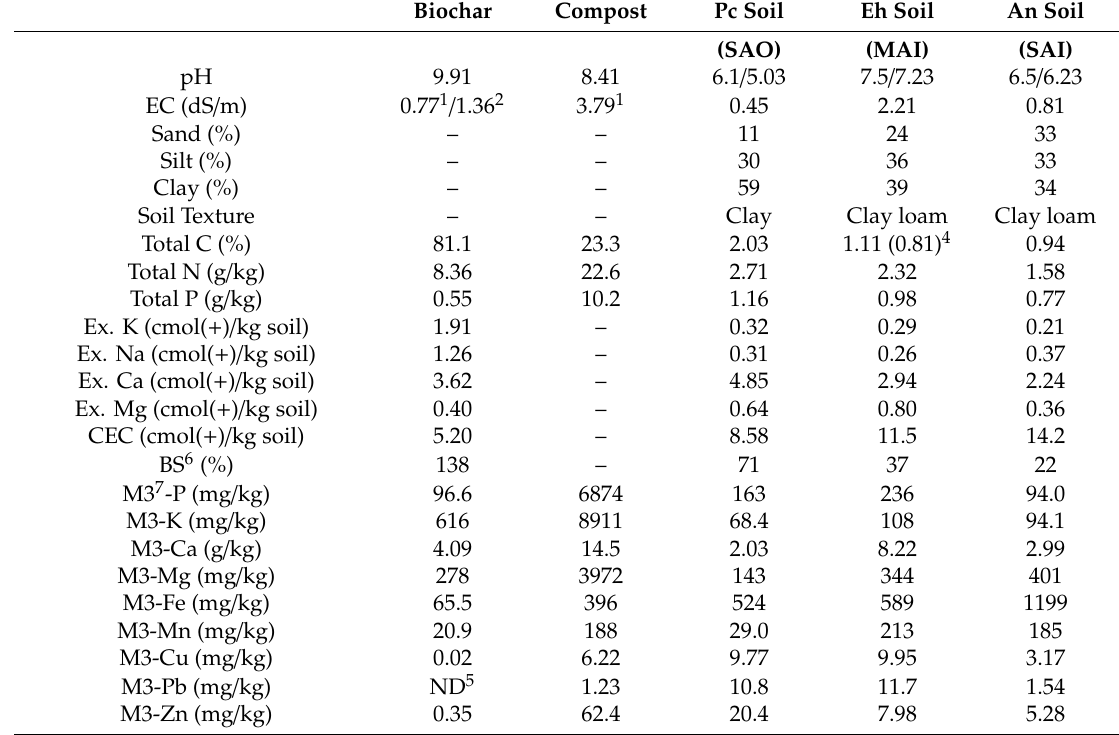
Table 1. Characteristics of biochar, compost, and three studied